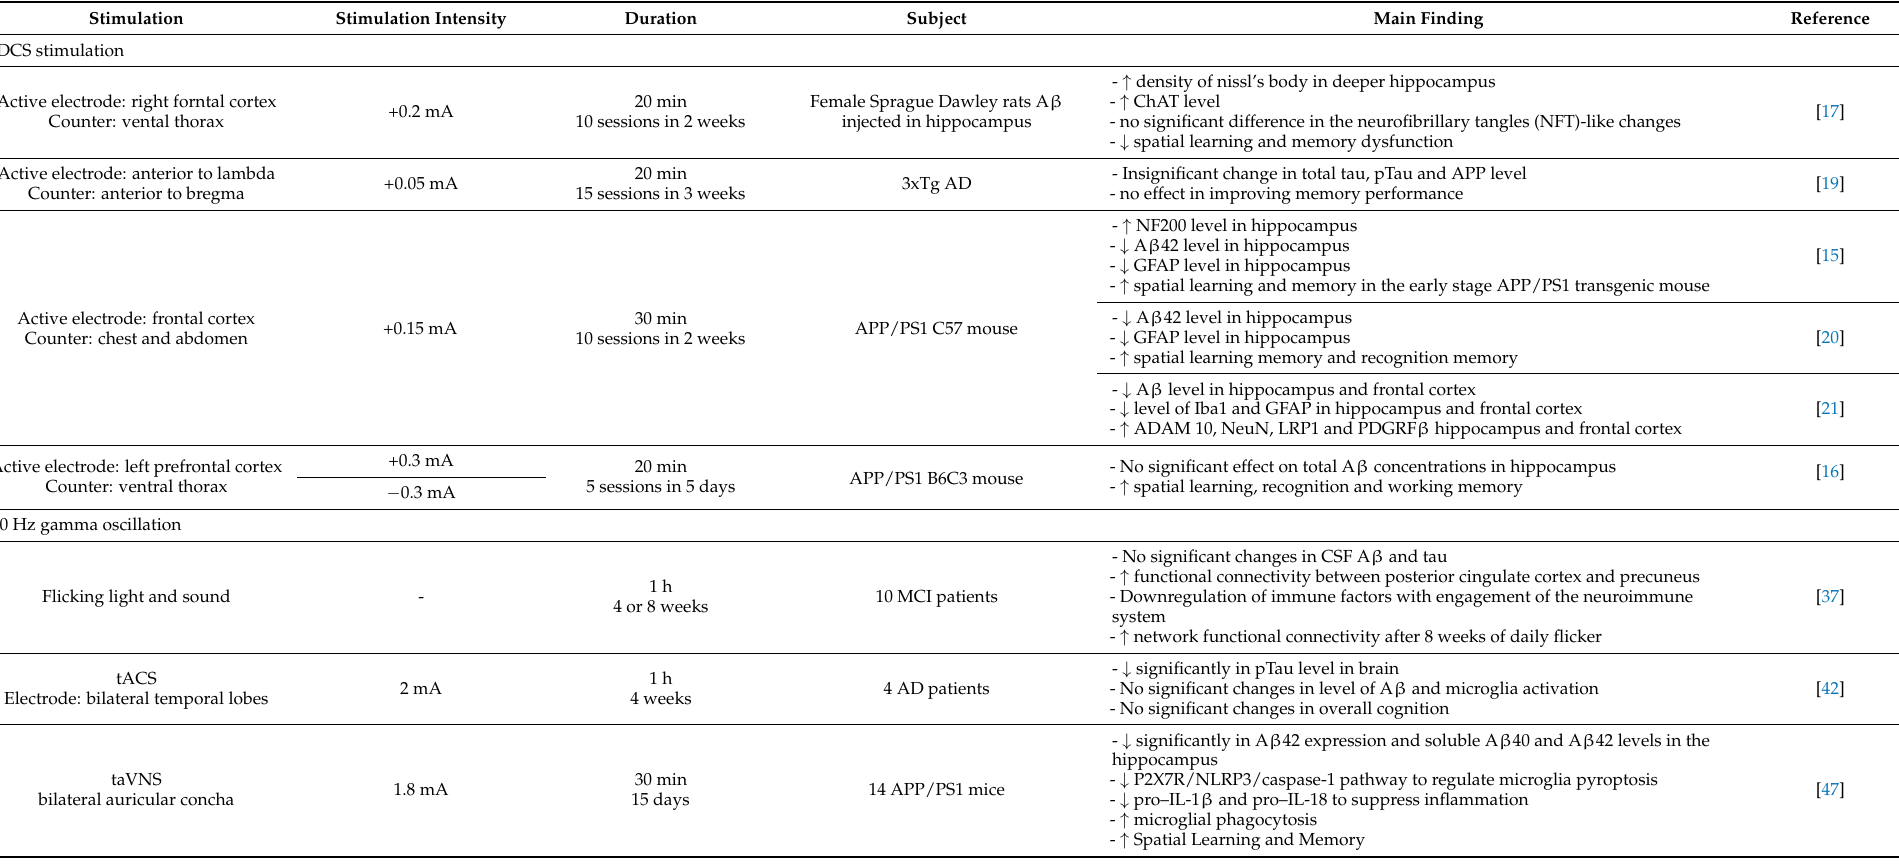
Table 1. A summary of electric stimulation on A β and tau